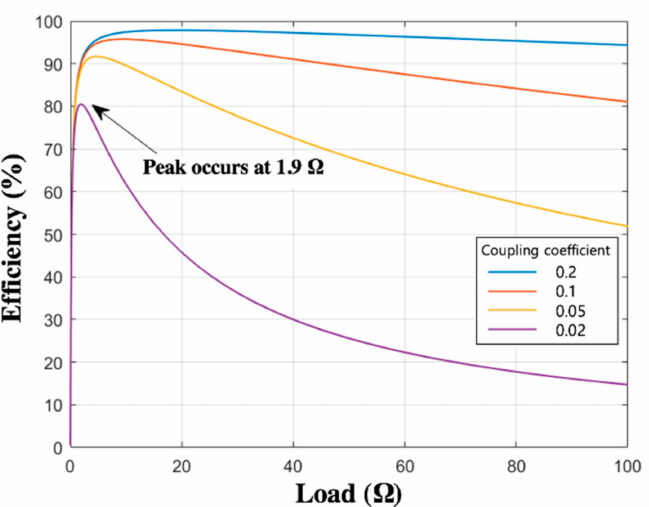
Figure 2. The power transfer efficiency of a conventional WPT system with a variable loading condition at different coupling coefficient